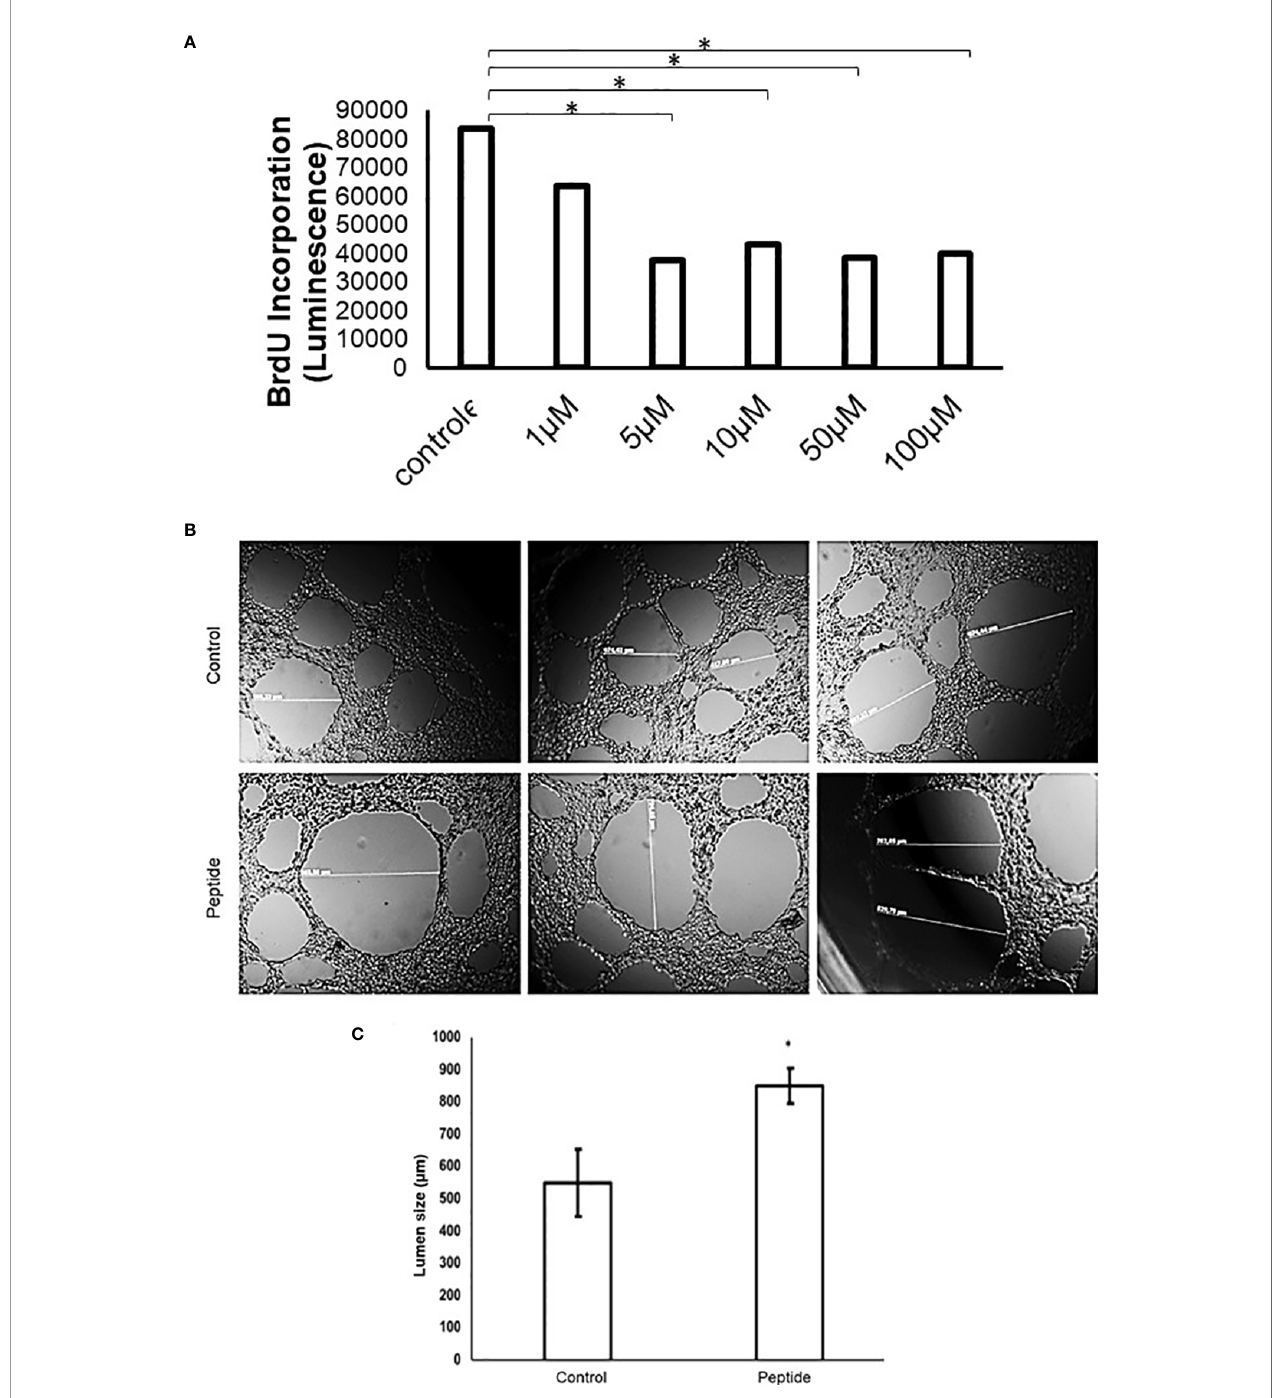
FIGURE 3 | Angiogenesis in vitro analysis. (A) Cell proliferation assay in the presence of HS-binding peptide. Proliferation assays were performed using BrdU as described in Methods. HUVEC cells were treated with the HS-binding peptide at different doses for 18 hours. After treatment, BrdU was added into the cell culture and luminescence was analyzed. Assay performed in triplicate, the bar represents average and lines represent standard deviation. The proliferation is inhibited from 1 µM of HS-binding peptide and reaches maximum inhibition at 5 µM. *p < 0.05 (Kruskall-Wallis). (B) Tubular formation with endothelial cells. Control, Cells remain in the absence of treatment. Peptide, Cells were treated with the HS-binding peptide (10 µM) for 18 hours. The tubular formation was analyzed by microscopy 20x magni fi cation. (C) Lumen size was measured, the bar represents average and lines represent standard deviation, *p < 0.05 (Kruskall-Wallis). Control, cells remain in the absence of treatment. Peptide, cells were treated with HS-binding peptide (10µM) for 18hours. It was veri fi ed that peptide was capable to inhibit the tubular formation of endothelial